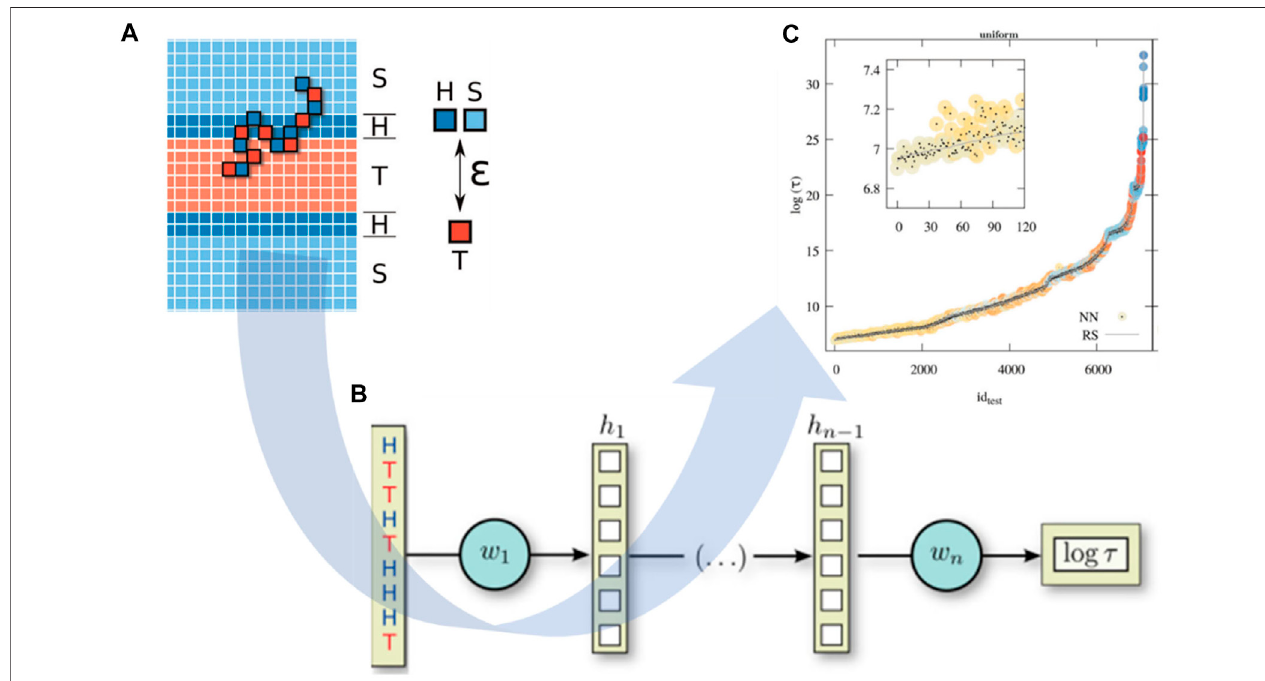
FIGURE 6 | Neural network model for predicting copolymer translocation through amphiphilic barriers. (A) CG polymer chains are adopted in membrane translocationsimulationswithalaterallyhomogeneousmembranesurroundedbysolventgrids.Herein,Hrepresentsahydrophilicgrid,Tforhydrophobiccore,andSas solvent. (B) NNsmodelisusedforpredictingthetranslocationtimeofapolymerasafunctionofhydrophilic/hydrophobic(H/T)sequence. (C) NNscanpredictaccurately thetranslocationtimeofsequence-de fi nedcopolymer(dots)comparedtoRS-basedresults(grayline)witharootmeansquaredrelativedeviationintheorderof1% for the logarithmic mean translocation time. Figure was reproduced from Ref. (Werner et al., 2020) with permission.